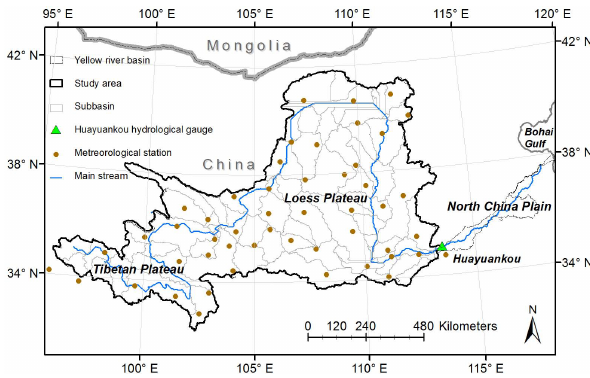
Fig. 1. The study area and